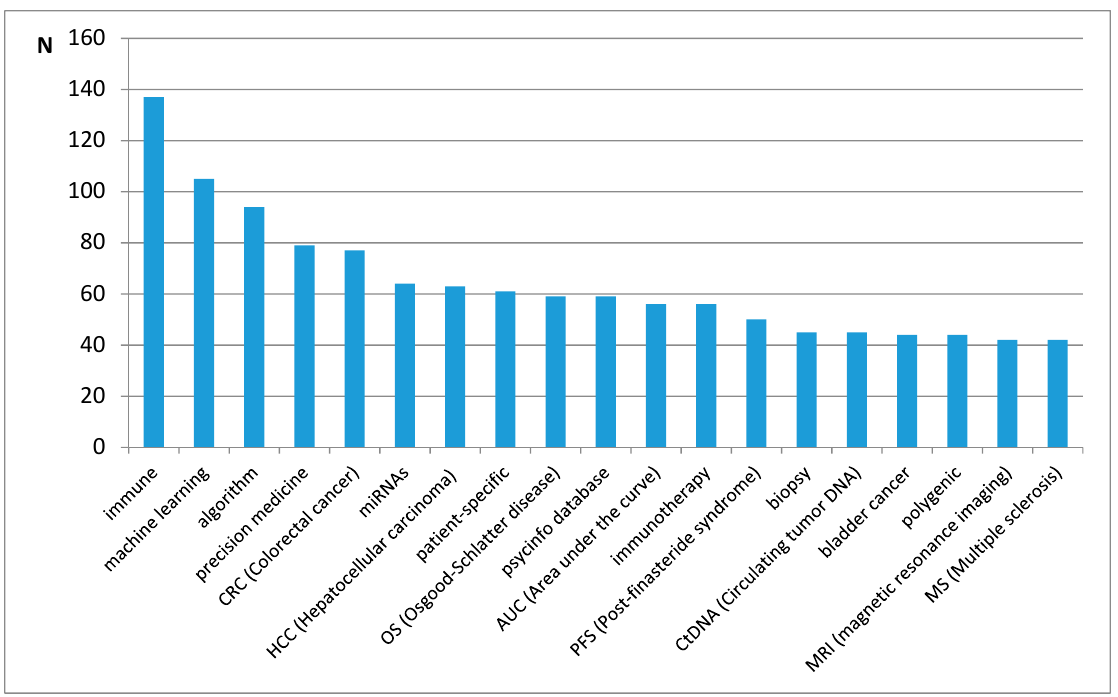
Figure 8. The frequency of occurrence of terms in the vicinity of the derivative “prediction” over the past decade. Int. J. Environ. Res. Public Health 2020 , 17 , x